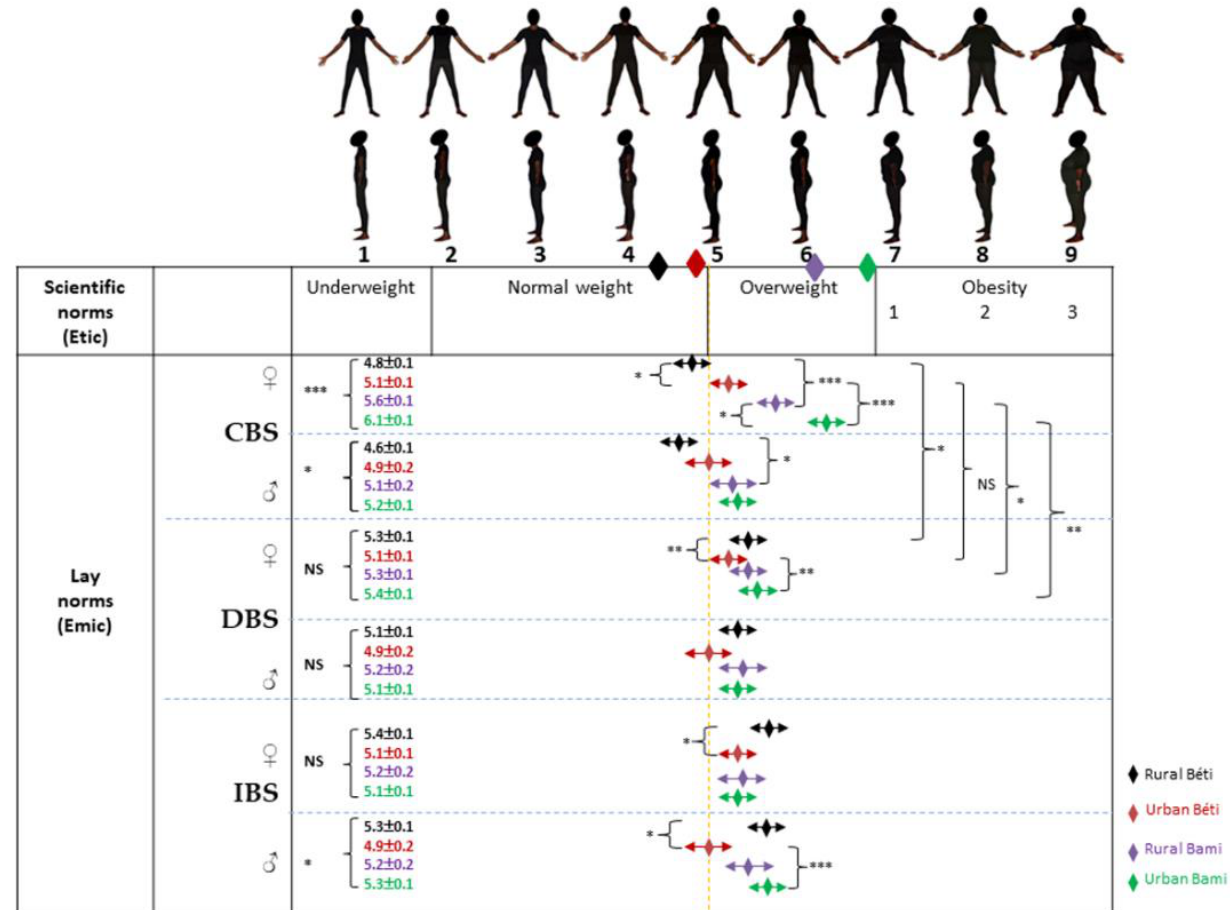
Figure 1. Perceptions of body size on masculine BSS. The diamonds just below the silhouettes cor- respond to the BMI averages of the four populations (rural Béti, urban Béti, rural Bami, and urban Bami). CBS: current body size; DBS: desired body size; IBS: ideal body size. ANCOVA between the four samples: * p < 0.05; ** p < 0.01; *** p < 0.001. Differences between CBS and DBS were tested using unpaired t -tests, * p < 0.05; ** p < 0.01; *** p < 0.001.